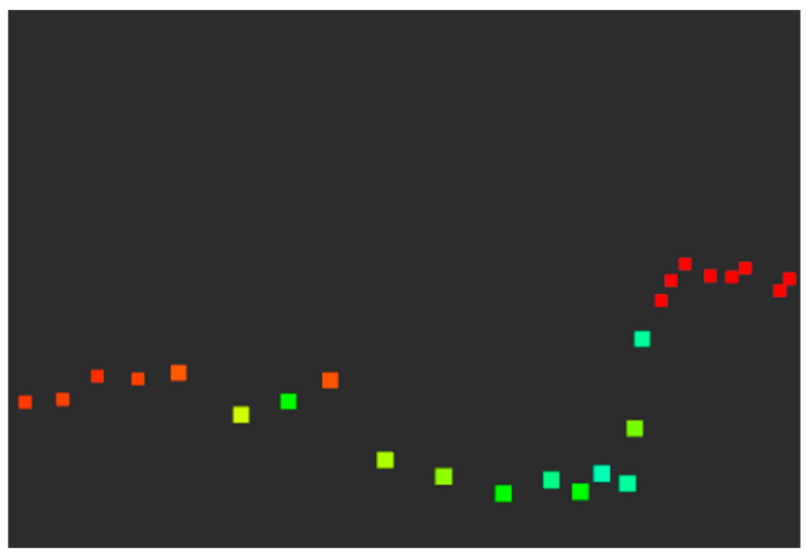
Figure 2. Convex hull. Some convex hulls that meet segment conditions are segmented from the raw point cloud.